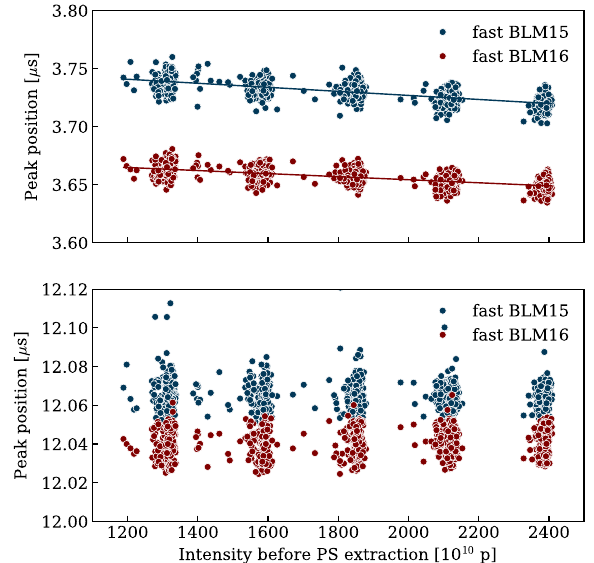
FIG. 13. Measured time of the peak losses for the island (upper) and the core (bottom) at the locations of the fast BLMs in SS15 and SS16. The linear shift is visible only for the